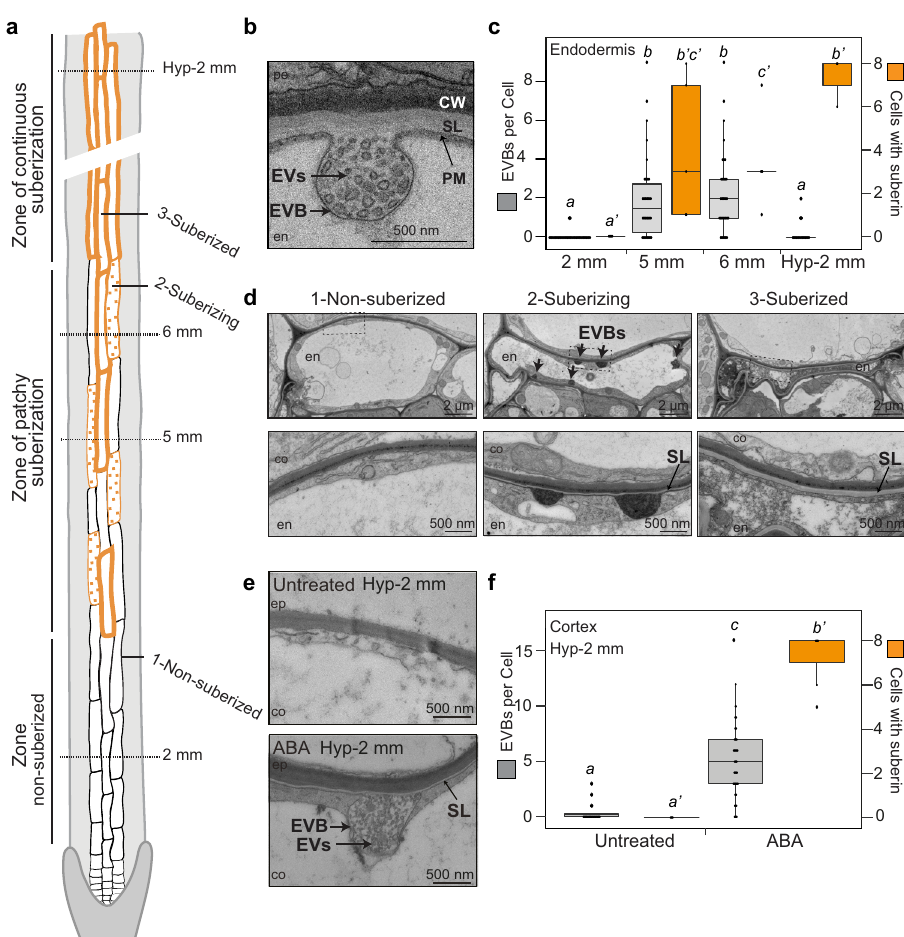
Fig. 3 Extracellular vesiculo-tubular membranes accumulate in suberizing cells. a Schematic view of suberin differentiation stages in roots. Positions along the roots are marked (2 mm, 5 mm and 6 mm correspond to positions from the root tip and Hyp-2 mm corresponds to position from the